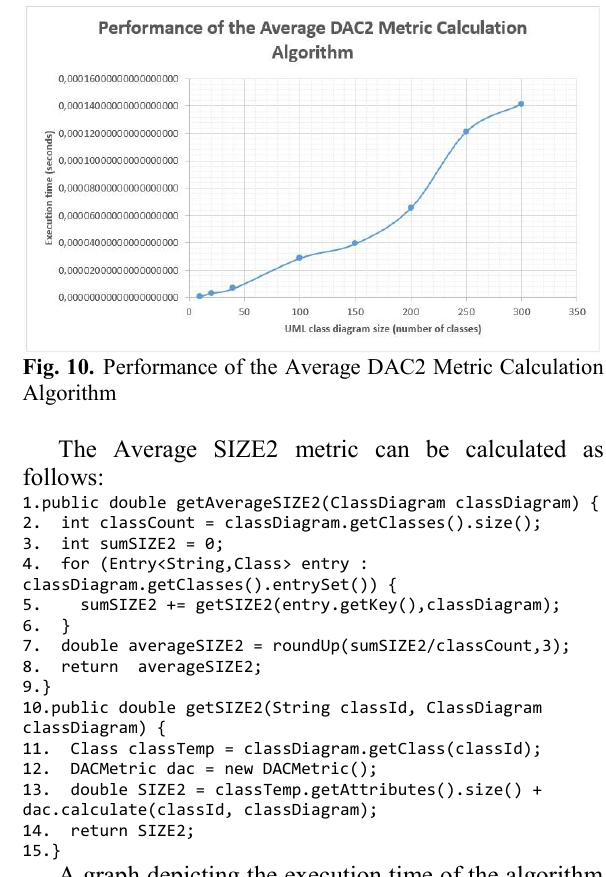
Fig. 10. The value of the execution time was calculated as for each UML class diagram size.